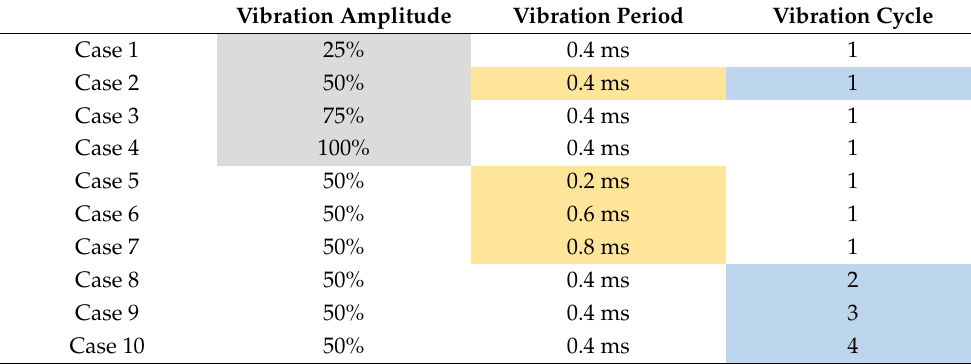
Table 3. Parameters of each